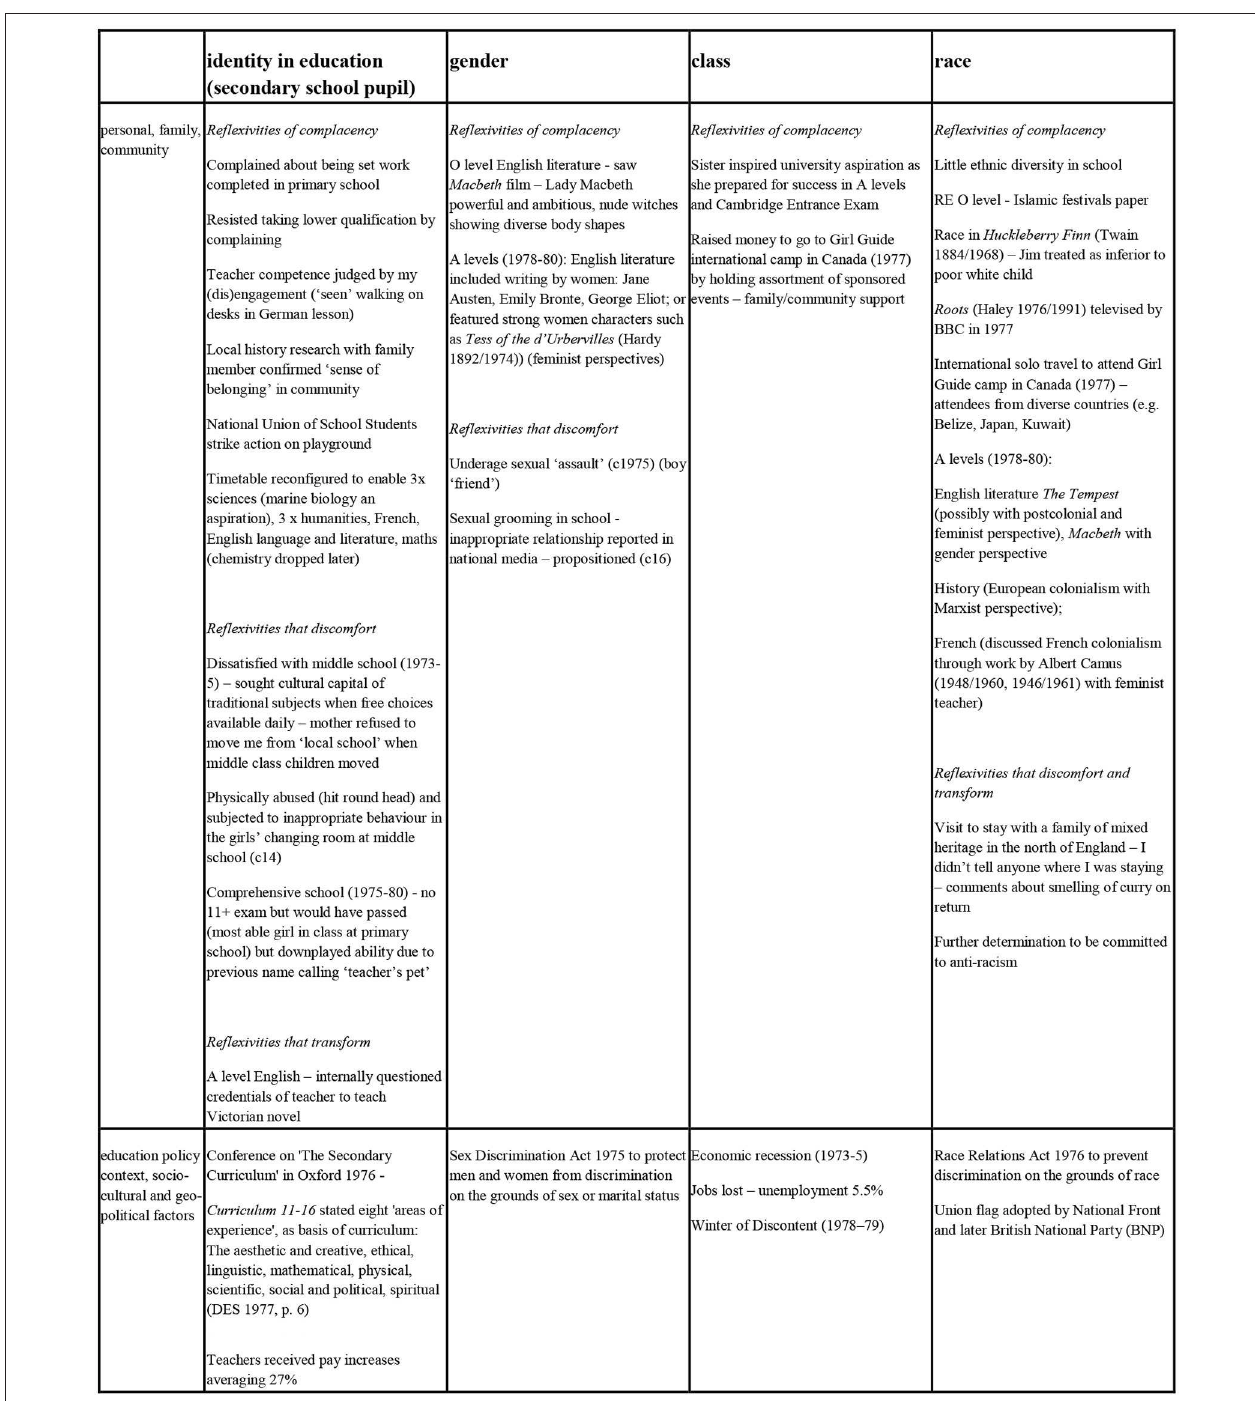
FIGURE 2 | Example of ‘7 up’ intersectionality life grid (14 − 1976) showing reflexivities of complacency, reflexivities that discomfort and reflexivities that transform .